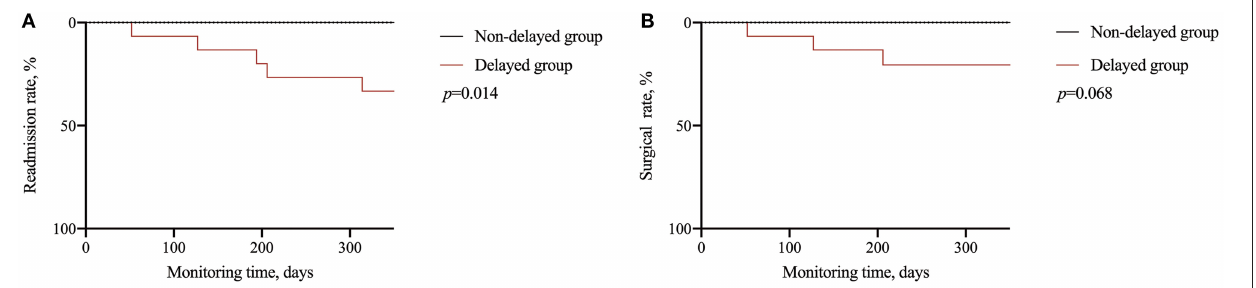
FIGURE 2 | Long-term effect of delayed treatment. (A) Comparison of readmission rate; (B) comparison of surgical rate.